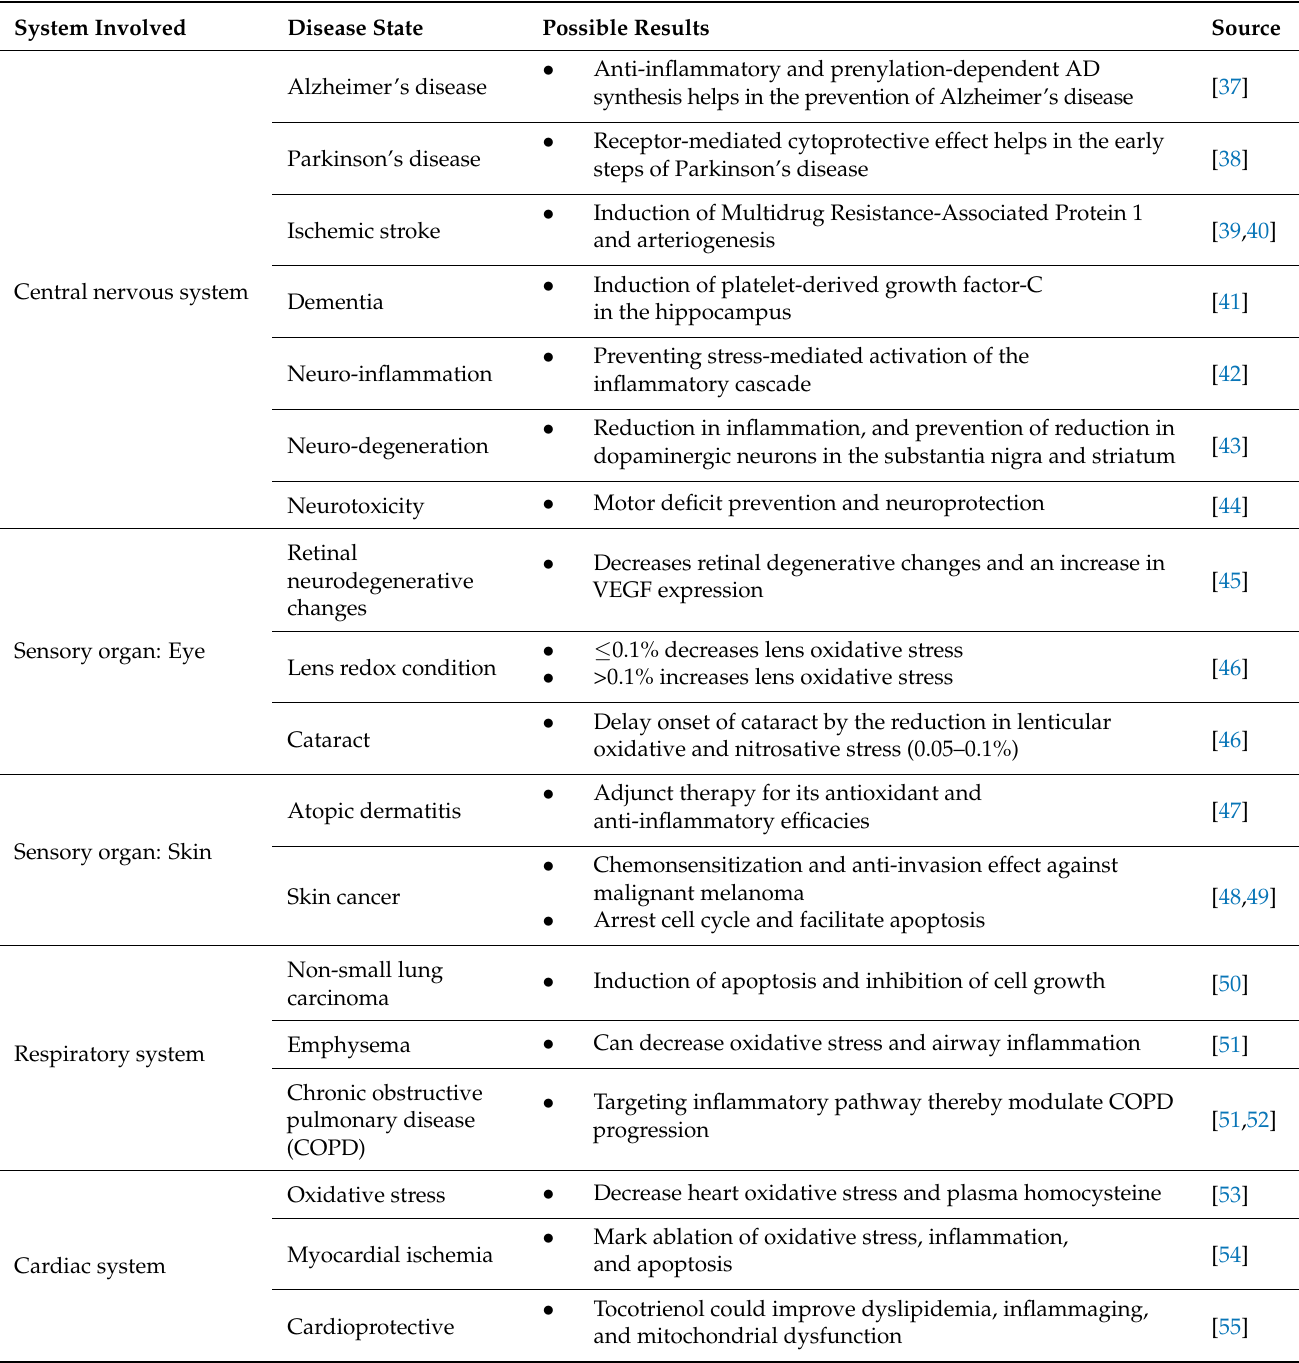
Table 1. A summary of health effects reported with